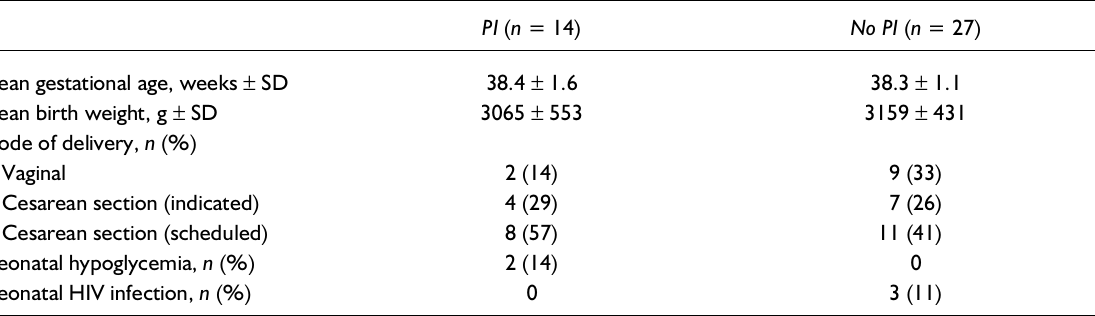
Table 2 Neonatal outcomes, comparing those mothers taking a protease-inhibitor-containing regimen (PI) at the time of glucola testing to those who were not (No